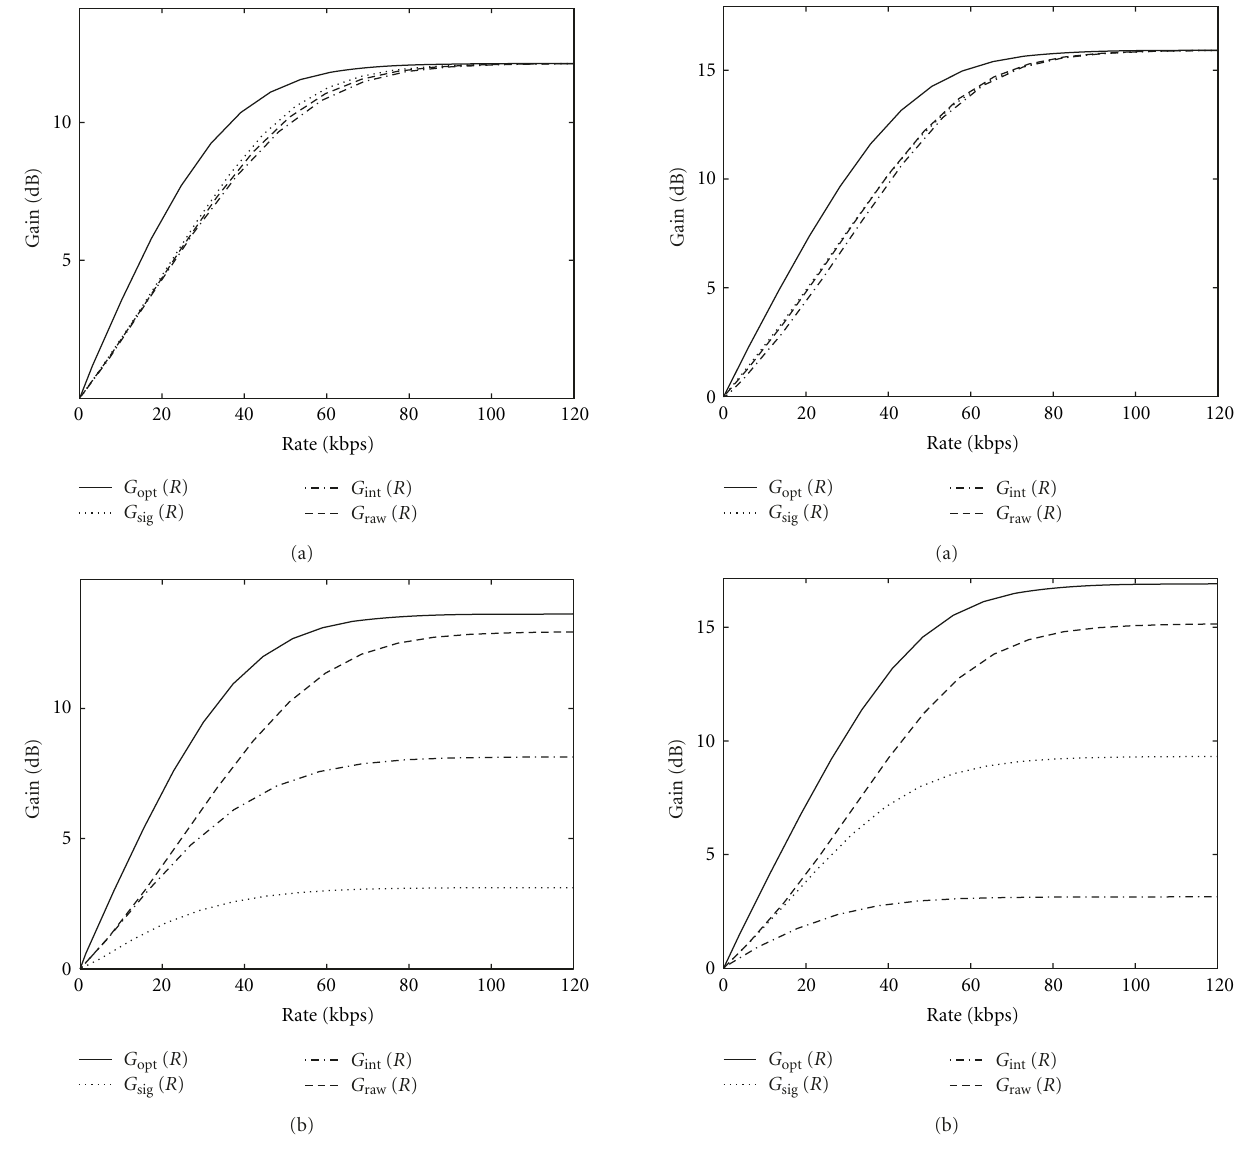
Figure 7: Performance gain for the di ff erent schemes when a desired signal is observed in the presence of uncorrelated noise at 20dB SNR and an interfering source at 0dB SIR located at 30 ◦ . (a) K = 1, (b) K =